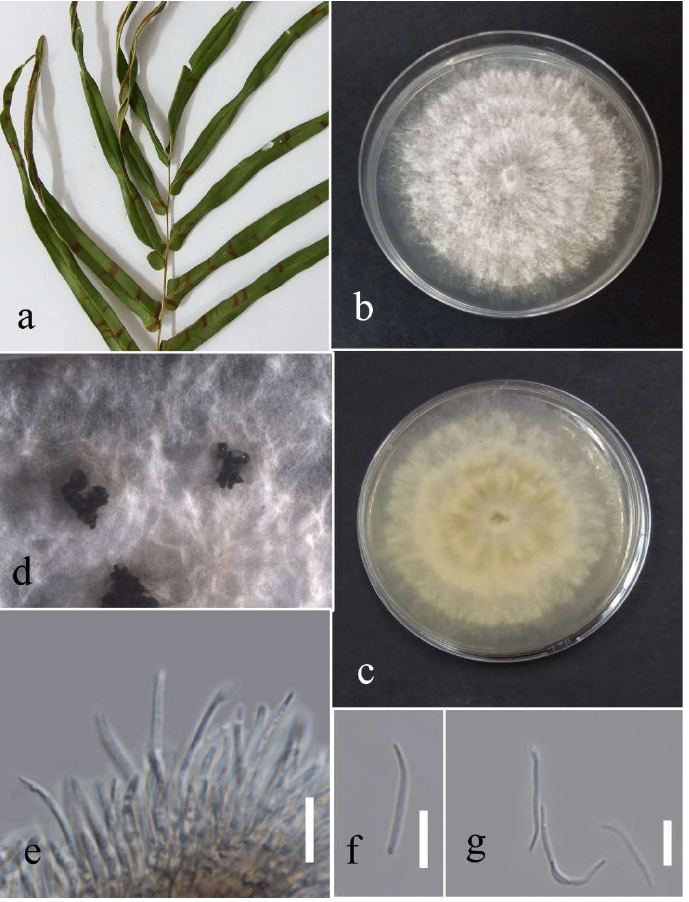
Figure 17. Morphology of Diaporthe delonicis (MFLUCC 22-0133): ( a ) leaf brown spots in Pteris grandifolia ; ( b , c ) upper and reverse views of the colony after seven days of growth on PDA at 28 °C; ( d ) pycnidia and conidial mass; ( e ) conidiophores; ( f , g ) beta conidia. Scale bars = 10 µm.